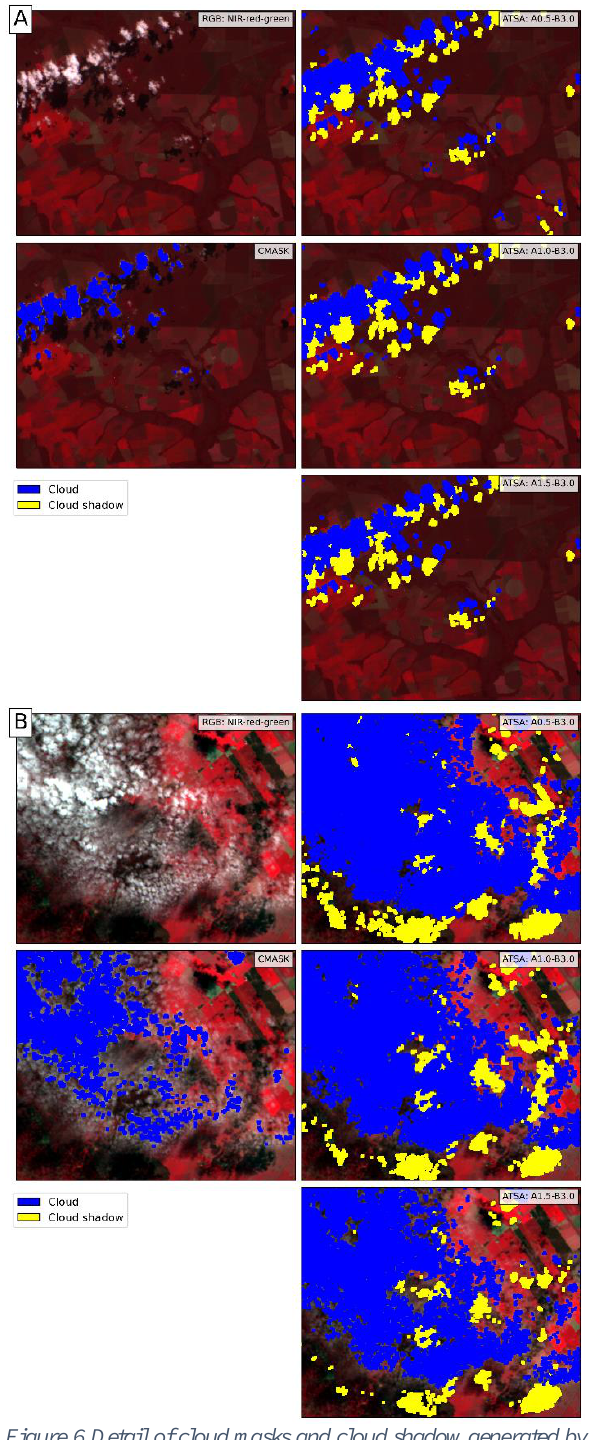
Figure 6 Detail of cloud masks and cloud shadow generated by ATSA (with parameter A equal to 0.5, 1.0, and 1.5, and B equal to 3.0) and by CMASK over images false-colour composite (RGB: NIR-red-green) for the subset of the image of the day 05- Jun-2020 in tile 21LYD (a) and day 28-May-2020 for the subset of tile 23LLG (b). The ATSA algorithm can better detect the edges of clouds and small clouds, and are able to detect shadows (Figure